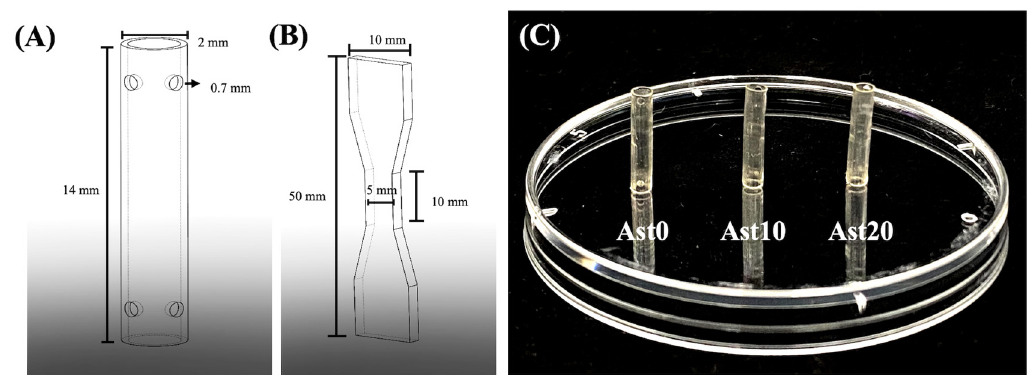
Figure 1. Schematic drawing of ( A ) the conduit and ( B ) the dumbbell-shaped sample used in mechanical testing. ( C ) A photograph of 3D-printed astragaloside (Ast)-containing polyurethane (PU) conduits.